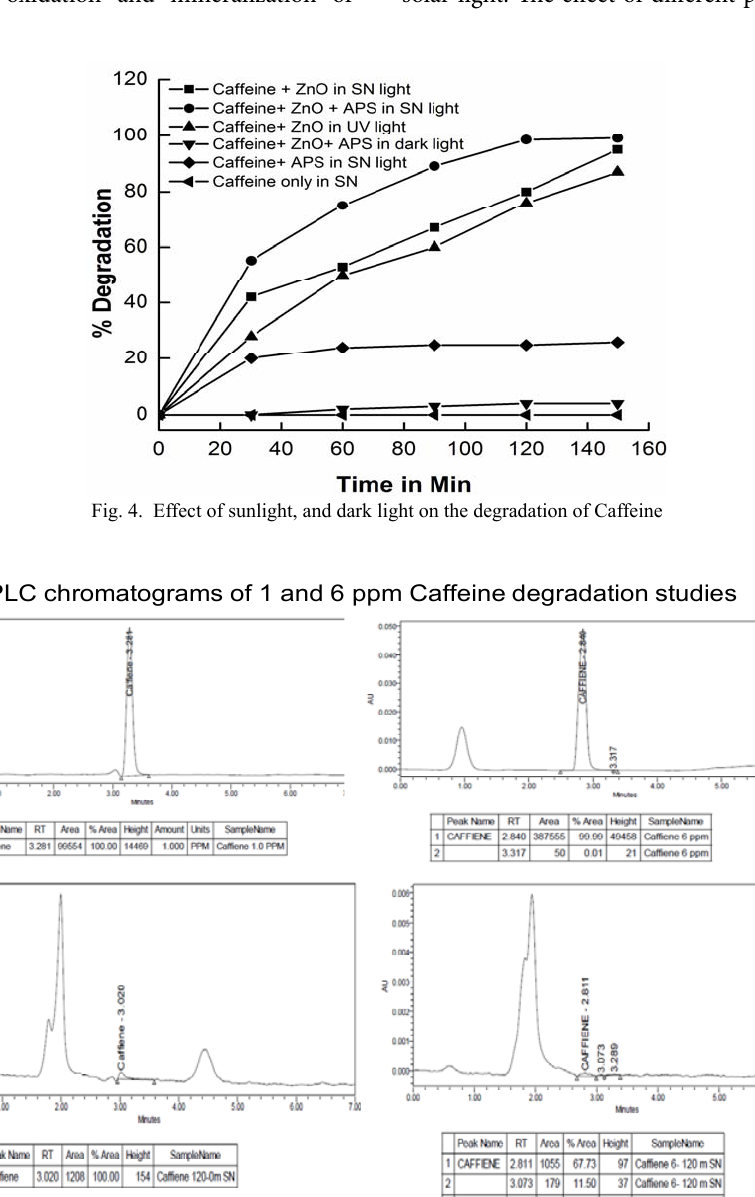
Fig. 5 HPLC Chromatograms of Caffeine standard solution and